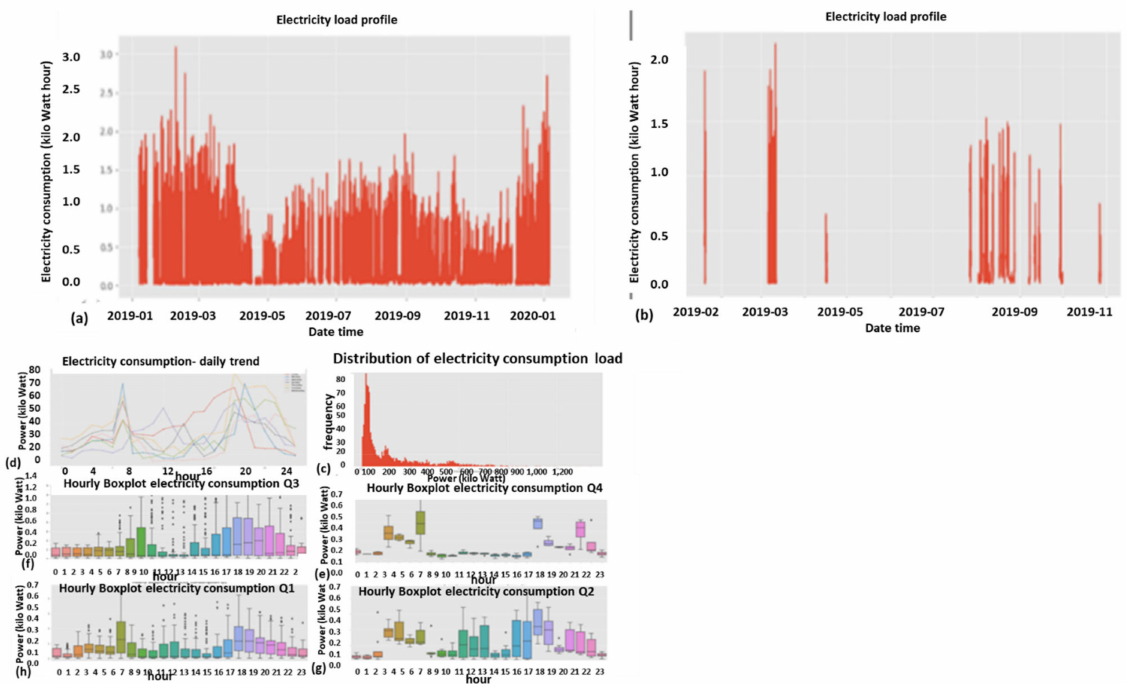
Figure 22. ( a , b ) Upper load profile does not propagate fully to the data warehouse, ( c ) shaved energy distribution, ( d ) daily-hourly trends are messy, ( e – h ) seasonal-hourly trends with plenty of